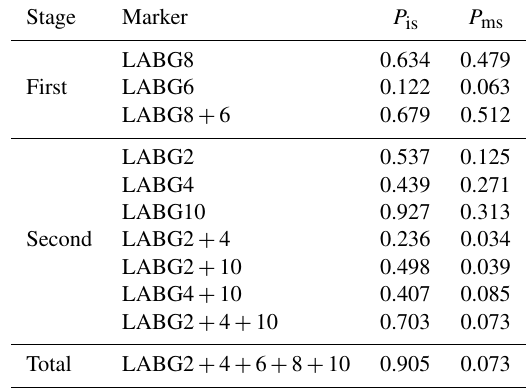
Table 6. Identification ( P is ) and misjudgment ( P ms ) probabilities of the Cholistani breed using different panels of markers. Stage Marker P